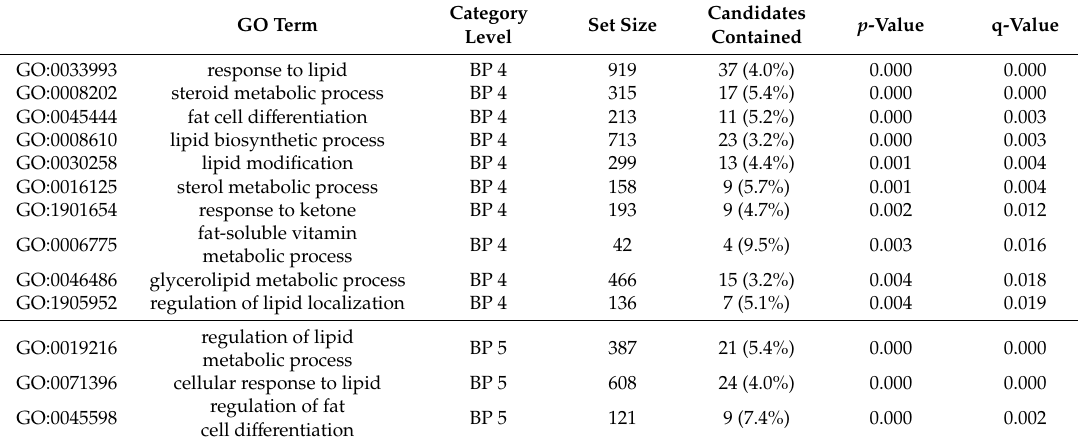
Table 1. Gene ontology (GO) terms related to lipid metabolism after GO enrichment analysis of the VitD altered genes in Ad-VDR HepG2 cells. Category GO Term Set Level